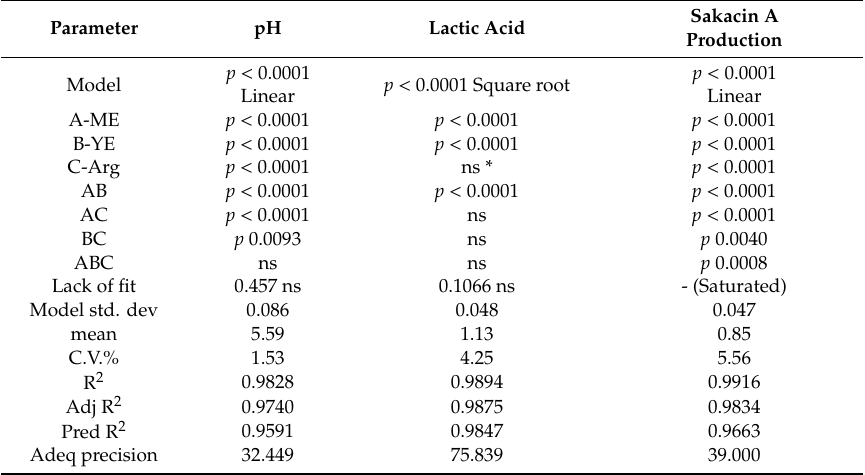
Table 4. ANOVA response, e ff ect estimates, models adaptation goodness as well as variability and noise ratio for each of the observed responses (pH, lactic acid and sakacin A production) of the experimental design reported in Table 3 ( α -out: 0.05).